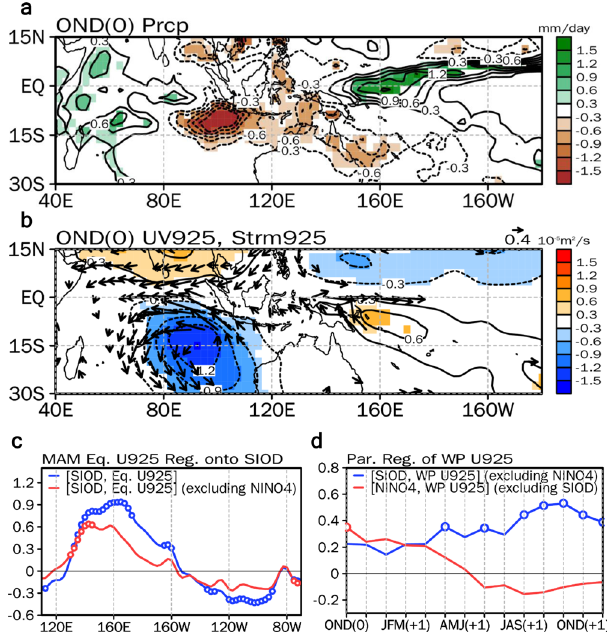
Fig. 3 | Atmospheric variance associated with the Southern Indian Ocean Dipole. Regression maps of ( a ) precipitation (mmday − 1 ) and ( b ) 925hPa wind (vector, ms − 1 ) and streamfunction (contours at intervals of 0.3·10 − 5 m 2 s − 1 ) anoma- lies during boreal late fall (OND) season with respect to the normalized OND SouthernIndianOceanDipole(SIOD)indexfor1998 − 2019.Theshadingandvector in a , and b denote the region where the statistical signi fi cance is above the 95% con fi dence level. c Regression of 925 hPa zonal wind anomalies averaged over 5° S – 5° N over the Paci fi c during the following boreal spring (MAM) season with respecttothenormalizedONDSIODindexfor1998 − 2019(blueline).Theredlineis the same but for the partial regression after excluding the impact of the boreal winter (DJF) Niño4 index. d Partial lag-regression of 925 hPa zonal wind anomalies averaged over 120° – 150° E, 5° S – 5° N over the equatorial western Paci fi c from the OND season to thesubsequentyear ’ sborealearly winter(NDJ)seasonwith respect to the normalized OND SIOD index after excluding the impact of the DJF Niño4 index for 1998 − 2019 (blue line). The red line is the same but for the partial lag- regression with respect to the normalized DJF Niño4 index after excluding the impact of the OND SIOD index for1998 − 2019. Theopen circles in c , and d indicate correlation coef fi cients thatare statistically signi fi cant atthe 95% con fi